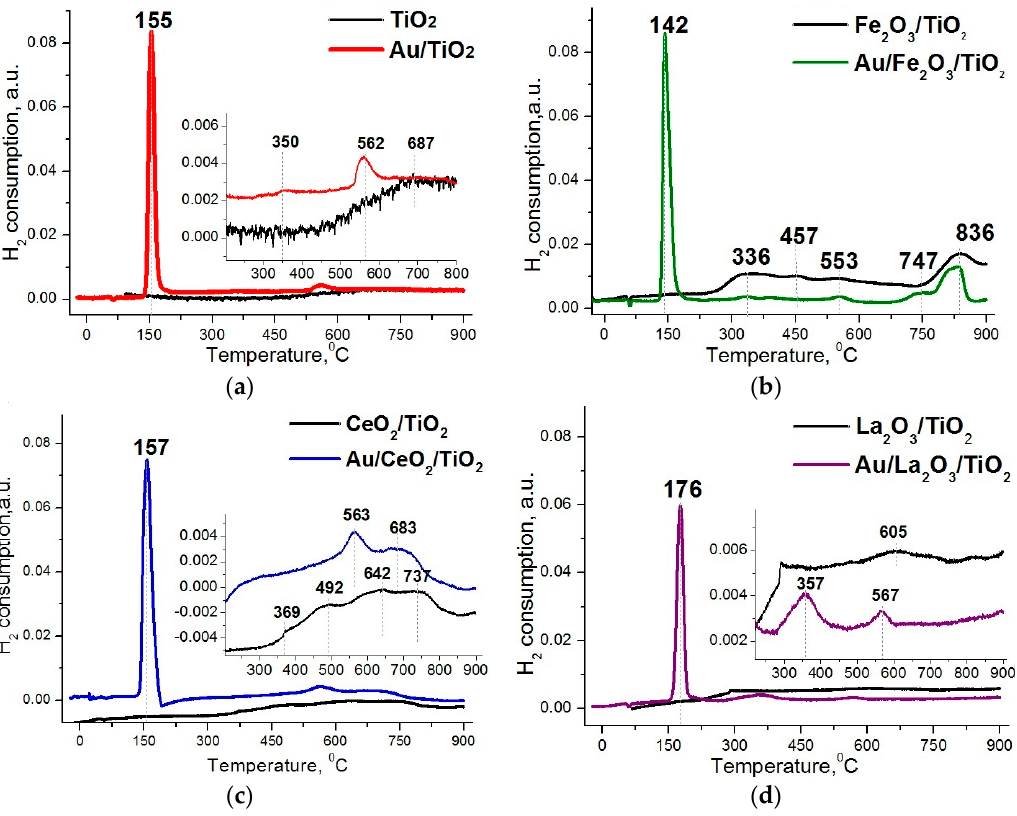
Figure 2. TPR profiles of Au/TiO 2 ( a ) and Au/M x O y /TiO 2 (M x O y = La 2 O 3 , CeO 2 or Fe 2 O 3 ) ( b – d ) catalysts in as-prepared state and their supports.